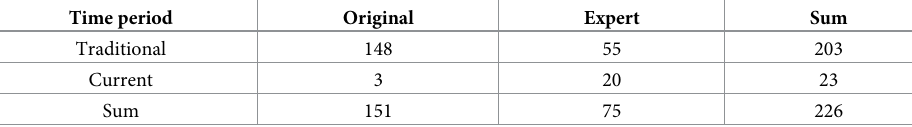
Table 2. The number of dataset files divided into the original published studies (original) and expert-modified distributions (expert) with two overall time